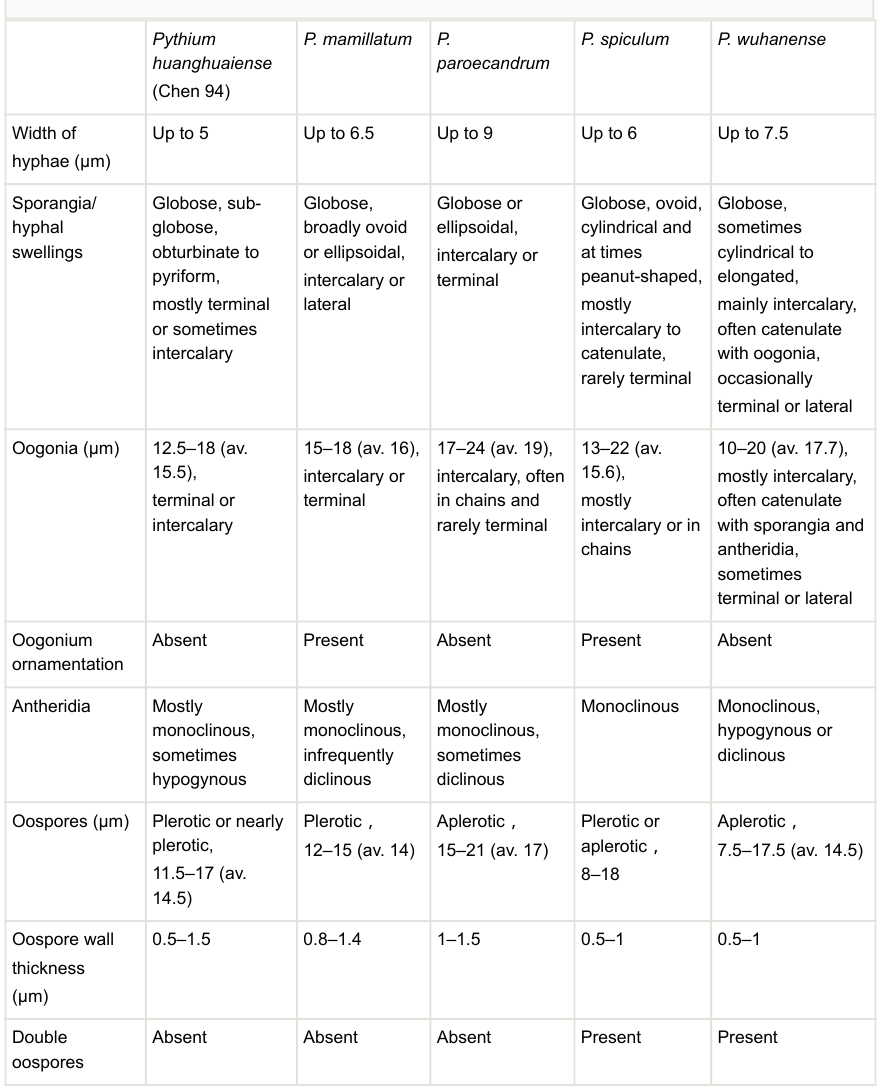
Morphological description of Pythium huanghuaiense and the most closely related